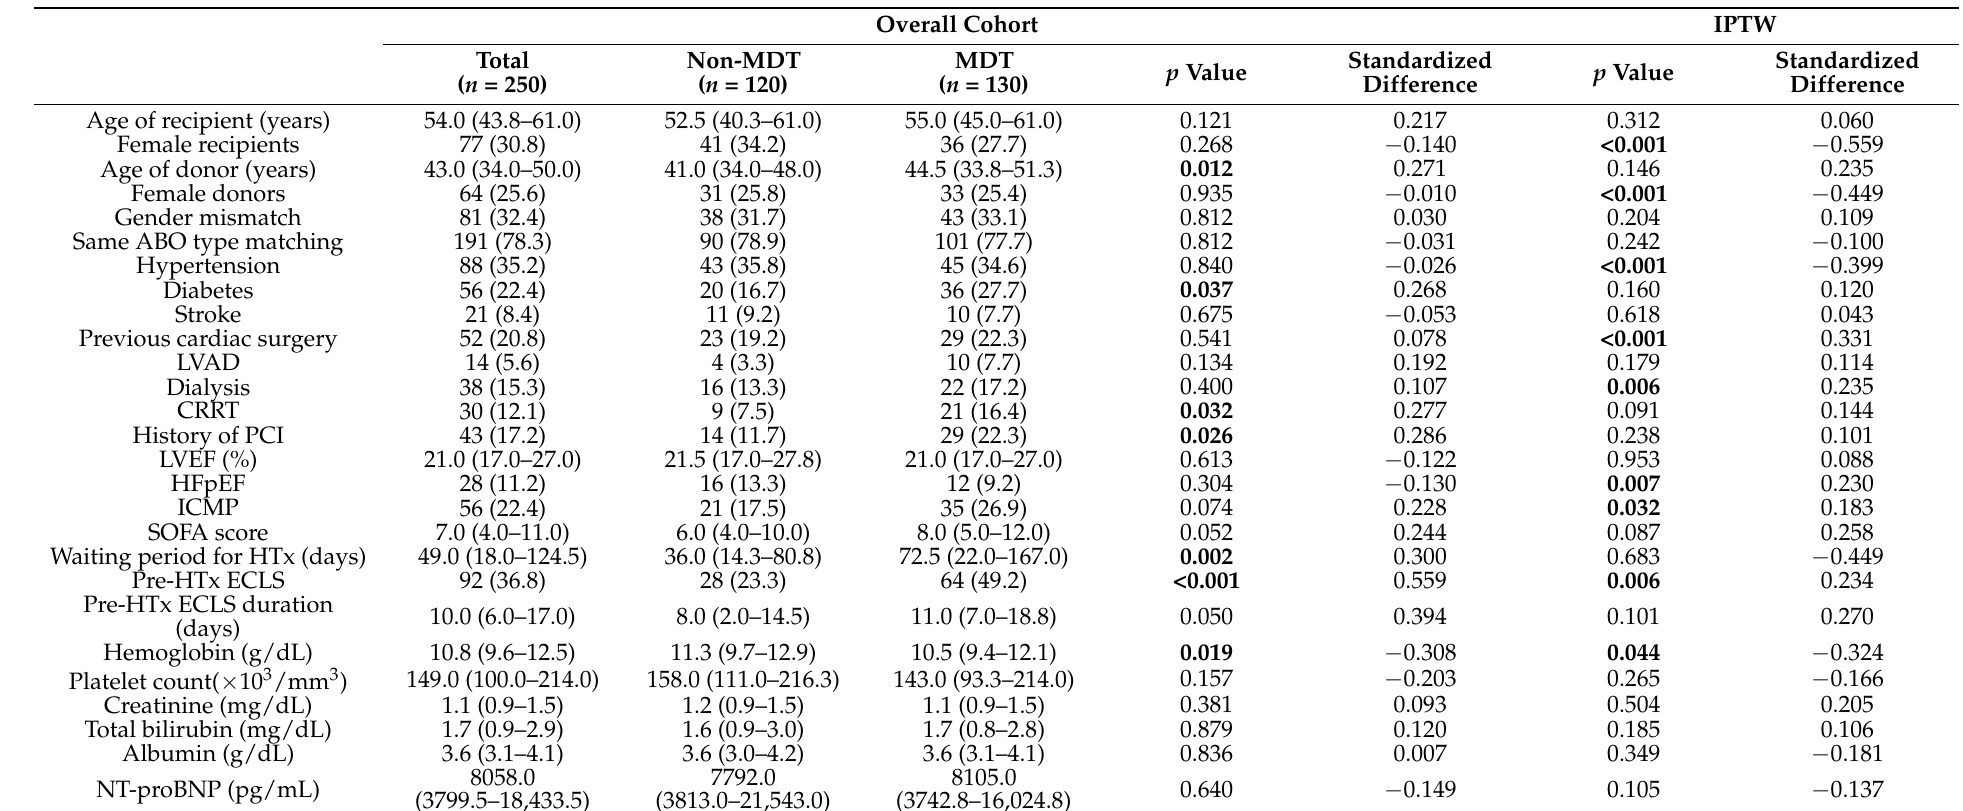
Table 1. Baseline characteristics of all